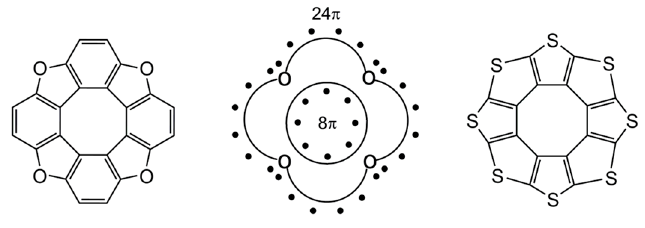
Figure 6. π -electronic structure of hetero[8]circulenes [46]. Chemistry 2021 , 3 , x. FOR PEER REVIEW